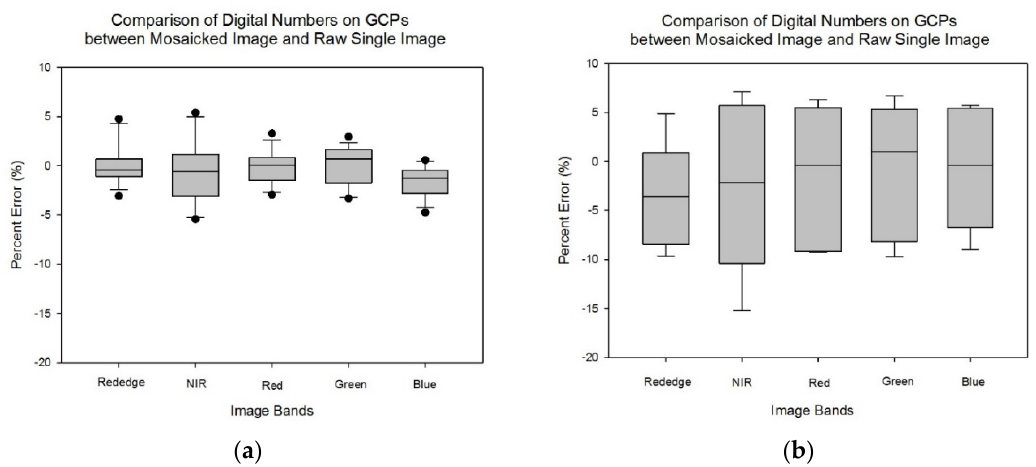
Figure 10. Comparison of the percentage error of the DNs on the reflectance reference panels obtained with two different moving patterns of the GCP along the farm road for every waypoint ( a ) and only odd-numbered waypoints ( b ).